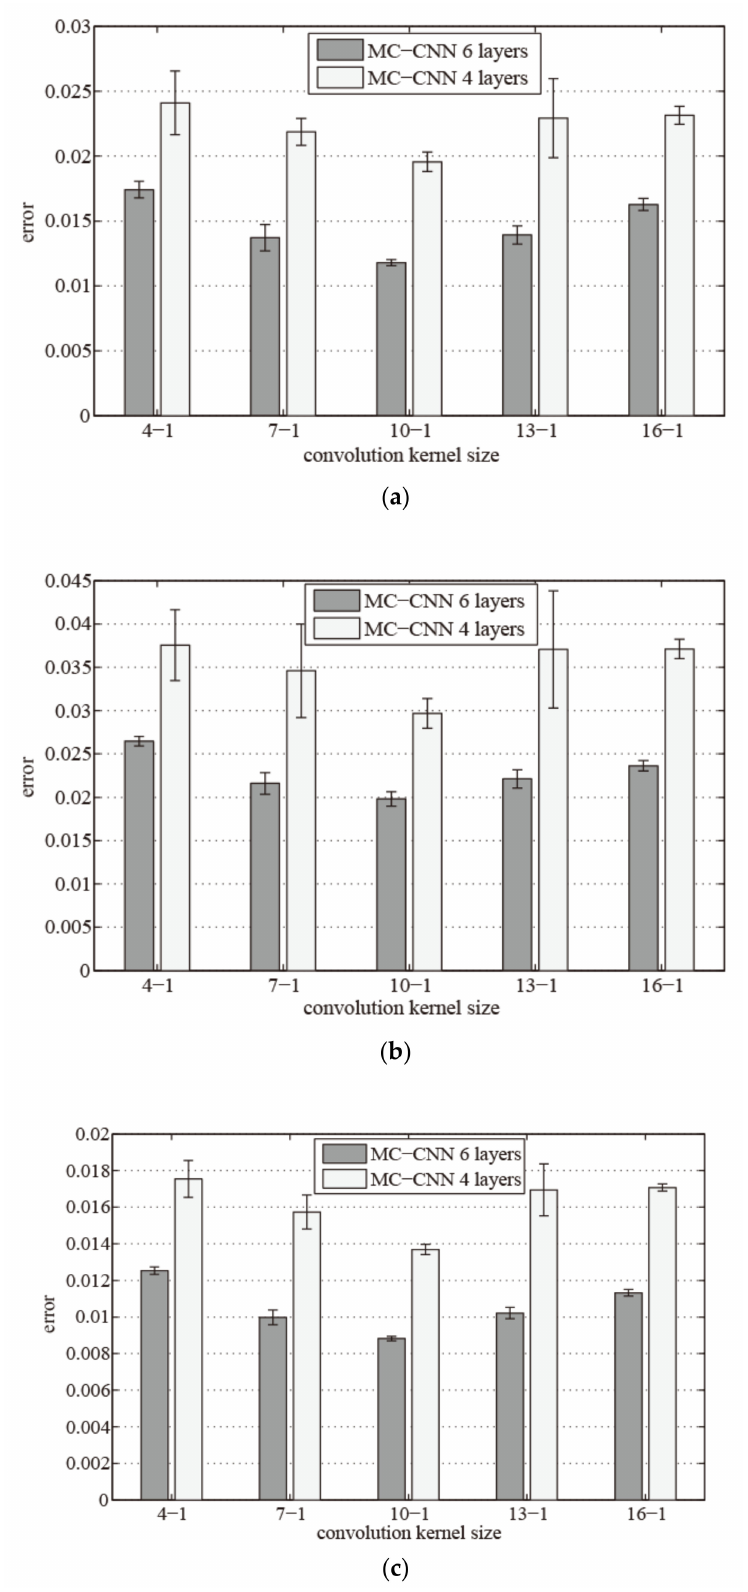
Figure 5. Error comparison of different structure MWMC-CNN. ( a ) RMSE comparison of different structure MWMC-CNN; ( b ) MRE comparison of different structure MWMC-CNN; and ( c ) MAE comparison of different structure